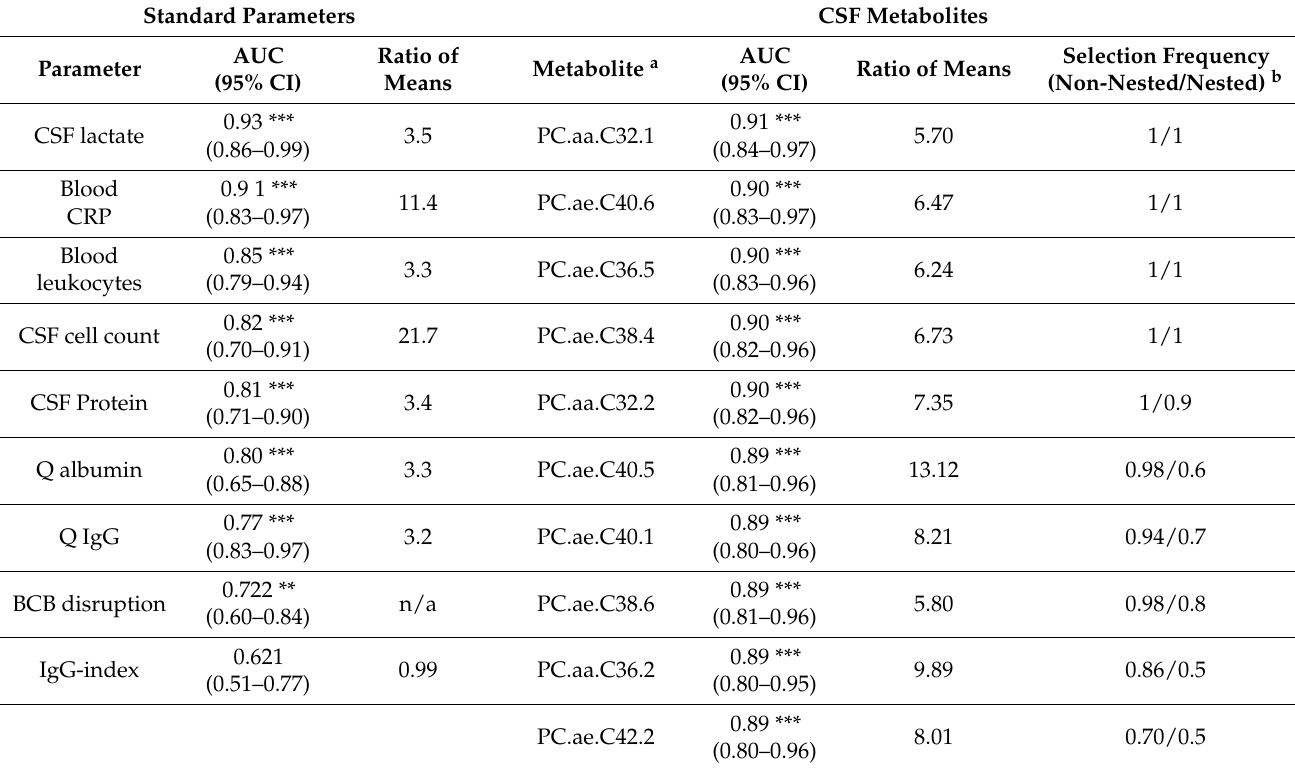
Table 2. Comparison of standard parameters and the 10 most robust CSF metabolite biomarkers to differentiate between bacterial meningitis and viral CNS infections.